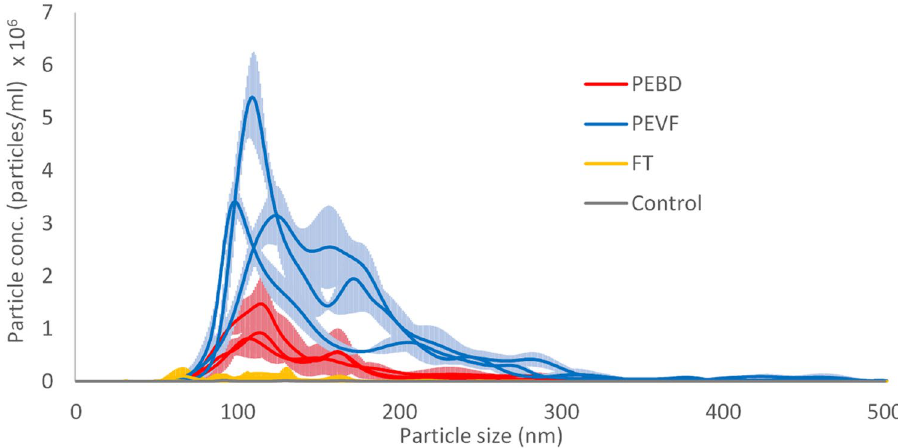
Figure 2. The size distribution of HDPE breakdown fractions determined by NTA. Each sample is an average from five recordings. The graphs represent the mean of these recordings and the lighter area around the graph represents the standard deviation from the runs. A control sample of the tap water is shown in grey line.